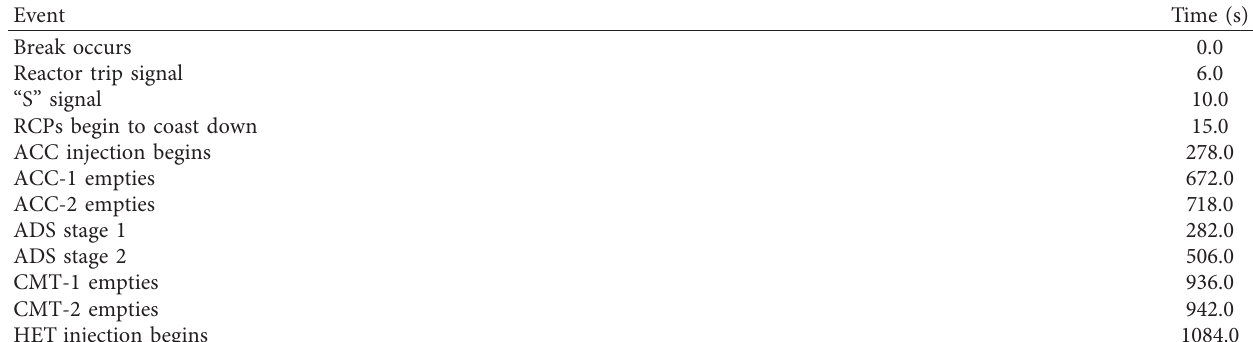
Table 5: DEDVI SBLOCA transient sequence of events.